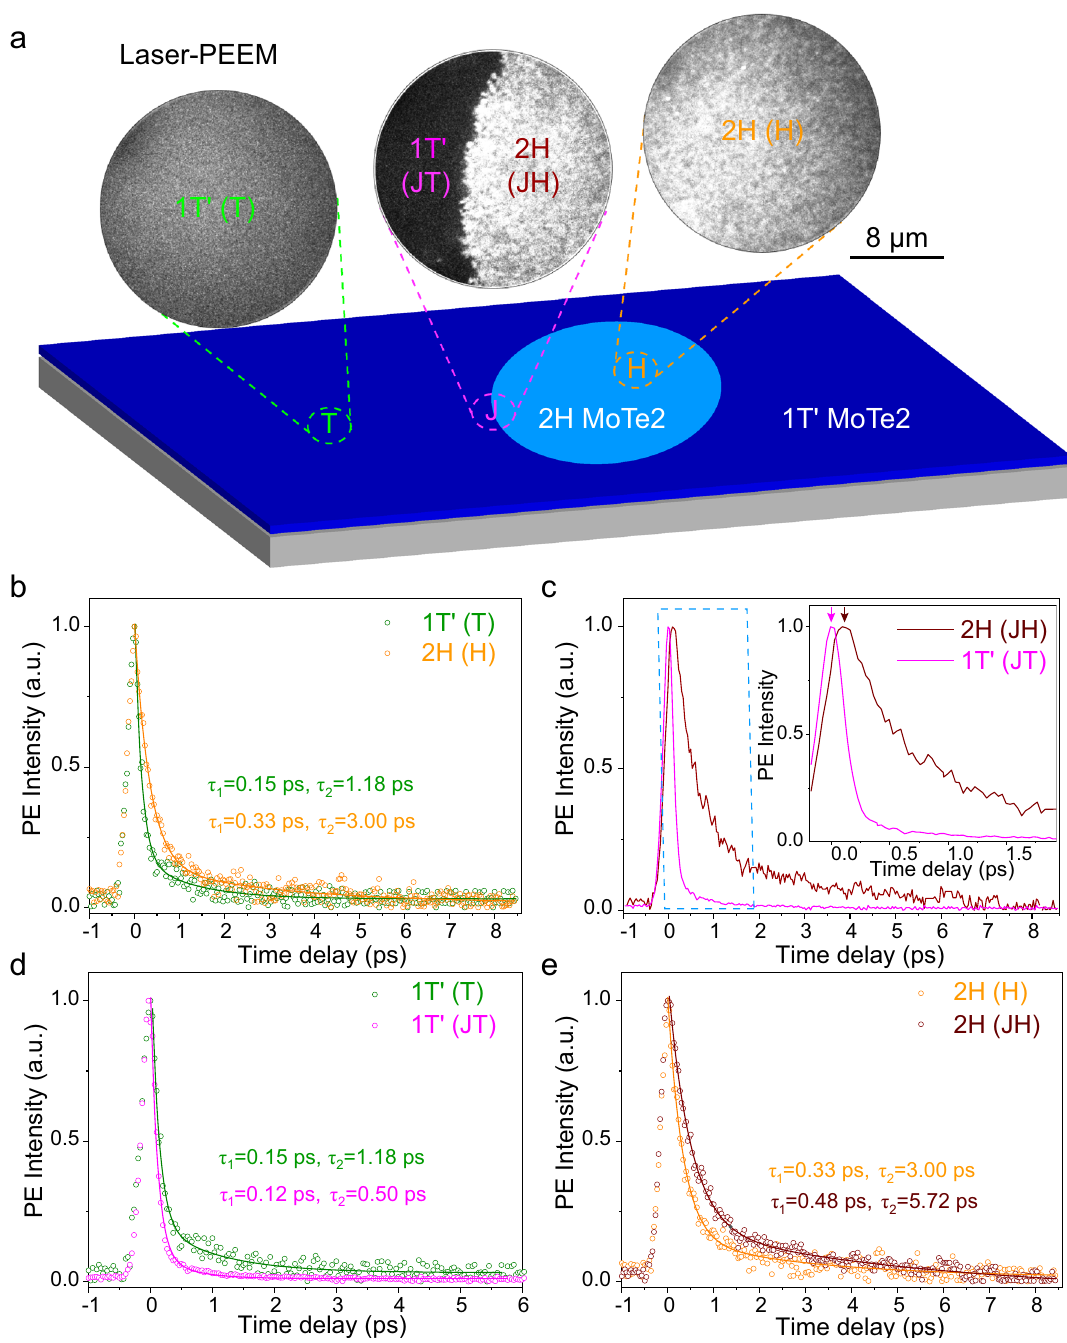
Fig. 4 Time traces of the PEIs. a PEEM images excited by the pulsed laser (Laser-PEEM; top) and the scale bar is 8 μ m. Schematic of spatially resolved measured regions (bottom). Pristine 1 T ′ -MoTe 2 , 2H-MoTe 2 , and heterojunction regions are labeled as T, H, and J, respectively. b , c Time traces of the PEIs for the T (green), H (orange), and J (magenta for JT and brown for JH) regions. Inset: zoomed-in curve within ~2 ps. d , e Comparisons of the PEI ’ time traces between T (H) region and JT (JH) region. The results of the PEIs were averaged of fi ve